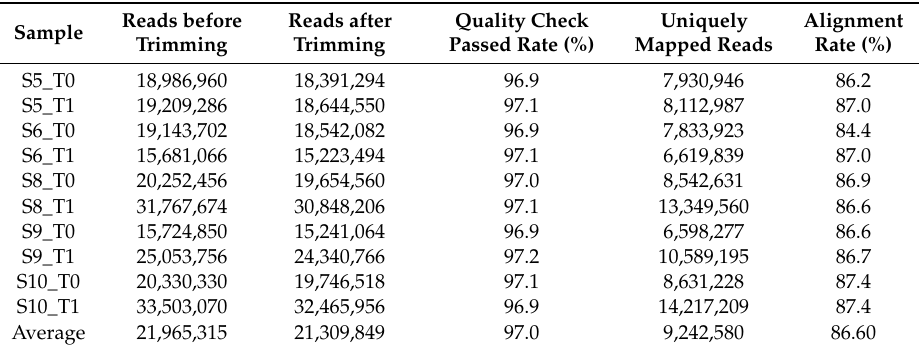
Table 1. Summary of sequencing results.